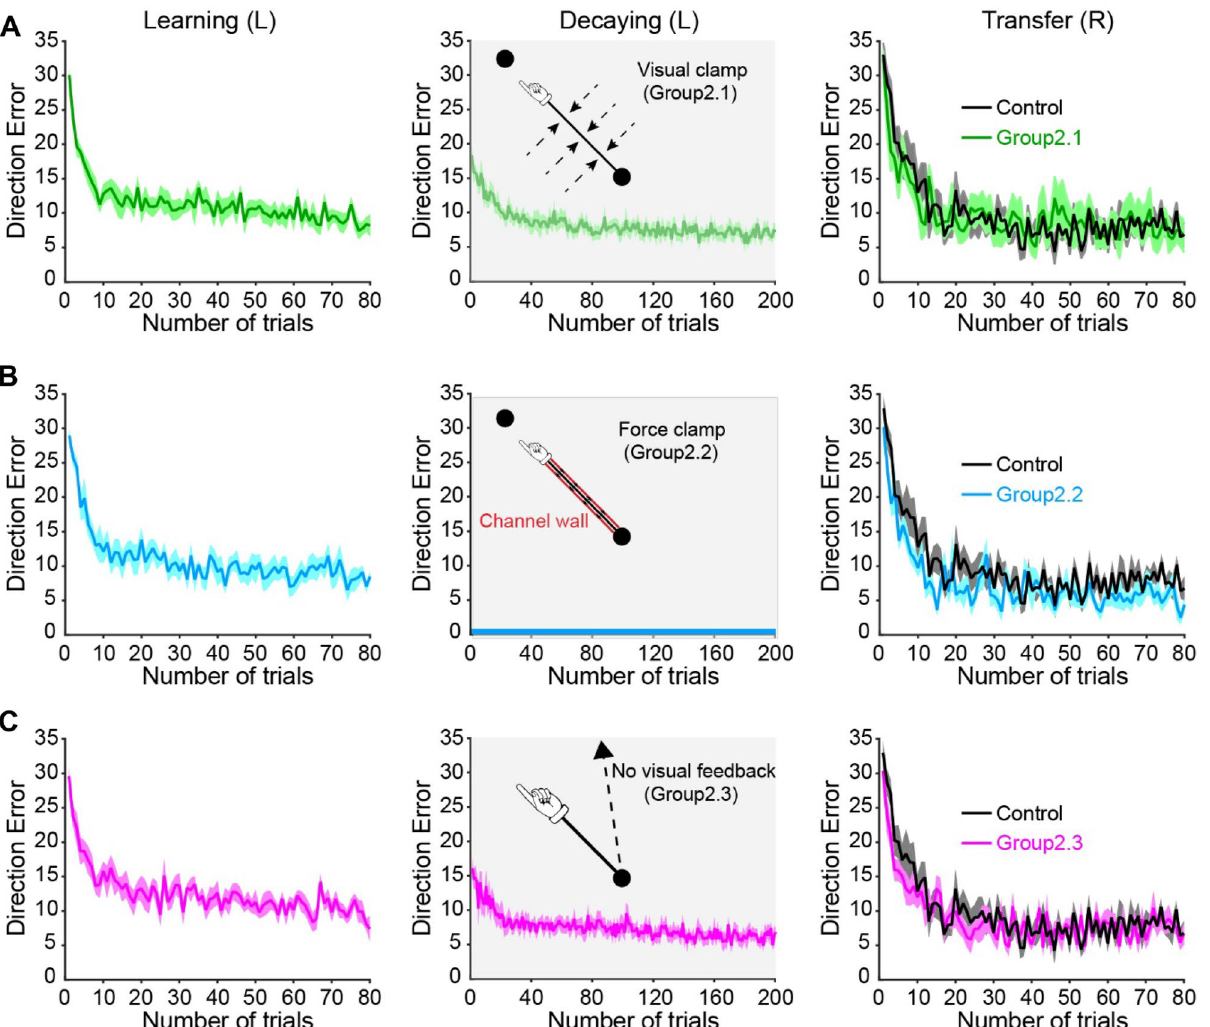
Figure 3. Performance for Experiment 2. ( A ) The movement errors of Group2.1 in the learning, decaying, and transfer sessions were plotted in green lines and shaded areas (mean ± standard error). During the decaying session, the cursor feedback was always on the straight line connecting the start and target circles. The black plot represented the control group’s performance in the transfer session. The performance of Group2.2 and 2.3 were depicted in ( B ) and ( C ), respectively. During the decaying session, a force channel restricted the hand-paths of Group2.2 along the straight line connecting the start and target circles, so the hand-paths were always straight and accurate. No cursor feedback was provided for Group2.3 during the decaying session, so the subjects reached towards the target based on their Group 3.2 experienced 200 “washout” trials and error-clamp trials, respectively (Fig. 5A–B, middle). The DEs were returned to baseline in both groups (Group3.1: asymptotic DE = 3.7 ± 0.9°, baseline DE = 4.9 ± 1.4°, p = 0.2; Group3.2: asymptotic DE = 7.1 ± 1.9°, baseline DE = 5.3 ± 2.2°, p = 0.1). Group3.1 exhibited smaller DEs by the end of the decaying session compared with Group3.2 ( p < 0.01). The subjects in Group3.3 sat idle for 860 s, which was the average amount of time taken by the subjects in Group3.1 and Group3.2 to complete the decay- ing session. During the transfer session, movement trajectories observed at trial 1 of the untrained effector was less deviated from the target line in Group3.3 (Fig. 6C, first column), whereas movement trajectories were noticeably more curved in Group3.1 and Group3.2 (Fig. 6A, B, first column). In agreement, average DEs from (Group3.1 = 31.6 ± 7.1°, p = 0.7; Group3.2 = 30.6 ± 6.8°, p = 0.4) and the control group (Fig. 6A, B, second column). Effector-independent motor memories were present in the form of savings in all three group (Fig. 6A–C, third